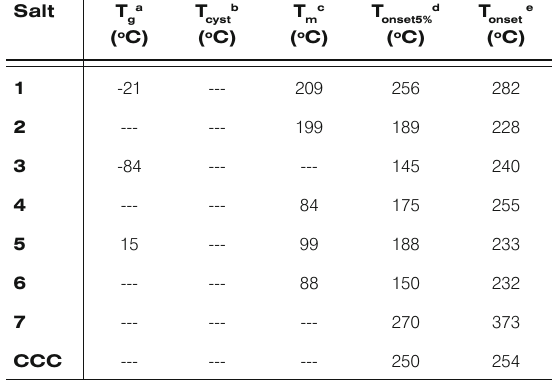
Table 3. The studied salts were thermally stable between